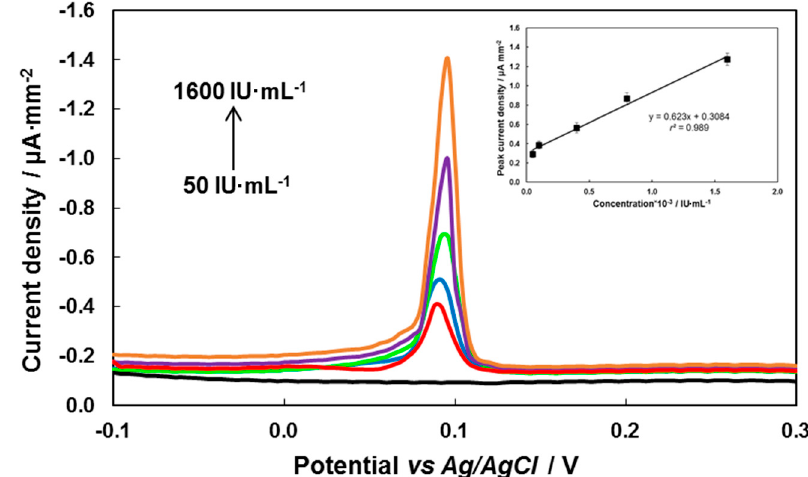
Figure 6. Cathodic linear sweep voltammograms of AgCl at the gold–carbon composite electrode (GCCE); black line—without the antigen immobilized on the immunosensor surface; coloured lines—antigen immobilized on the electrochemical immunosensor with the different concentration of antibodies (50, 100, 400, 800, 1600 IU·mL − 1 ). Inset plot: corresponding calibration curve (error bars for n = 5, P = 0.95) in supporting electrolyte of 0.15 mol·L − 1 HNO 3 and 0.01 mol·L − 1 KCl. Scan rate of 100 mV·s − 1 , E acc = − 0.8 V, t acc = 60 s.